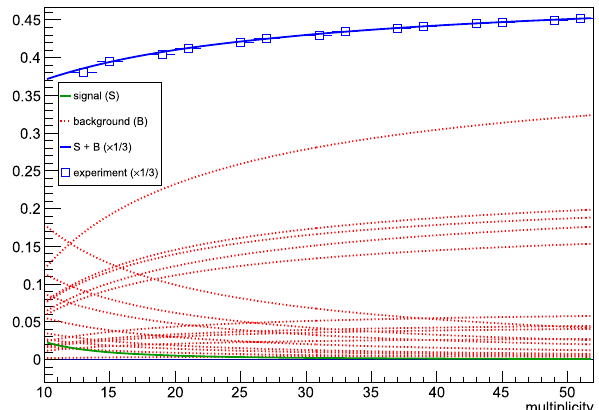
Fig. 5 Example analytic description of combinatorial background in three-particle correlations, when particles are produced in triples, and the final data sample is